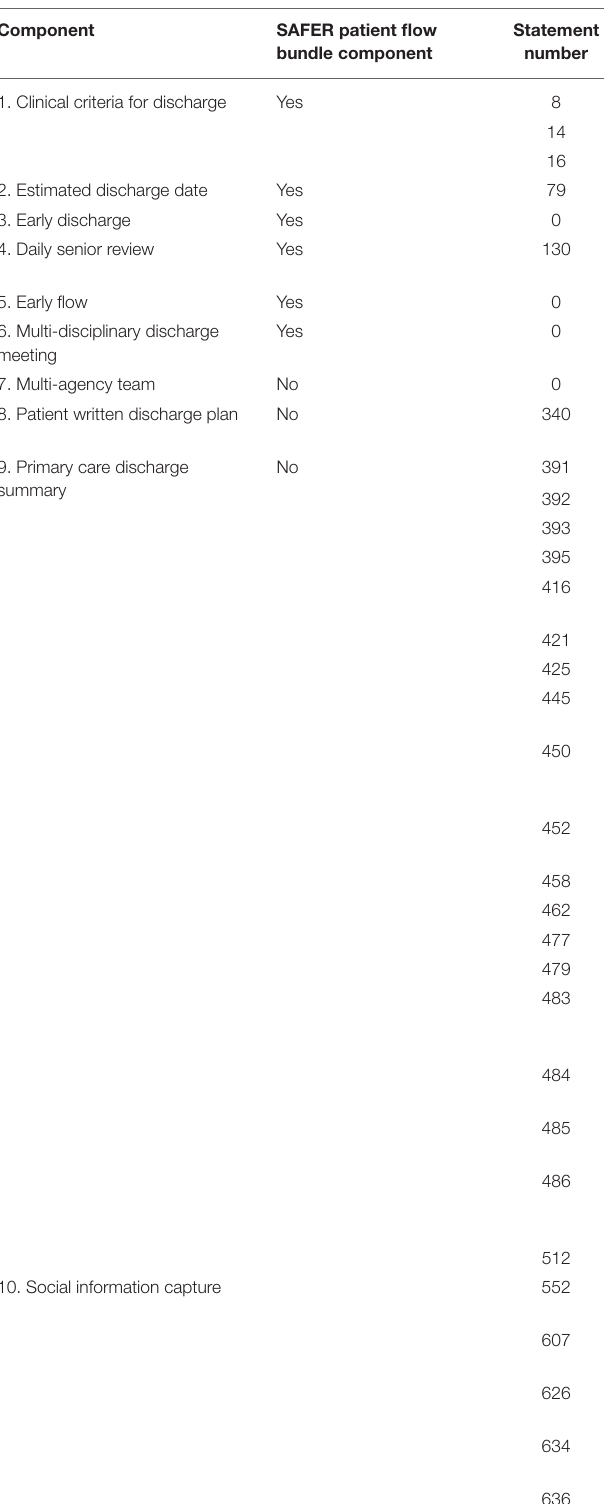
TABLE 2 | Statements rated most highly—appropriate (median 9, DI < 1) and feasible (median ≥ 7, DI < 1) (created by authors).